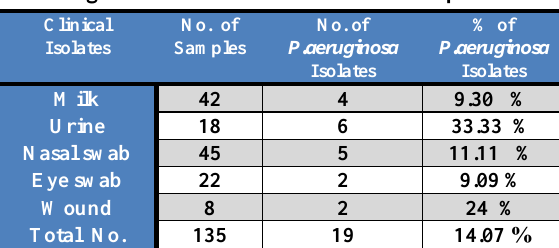
Table, 1: No. of P. aeruginosa isolates and there percentage from different infection in sheep. Clinical Isolates